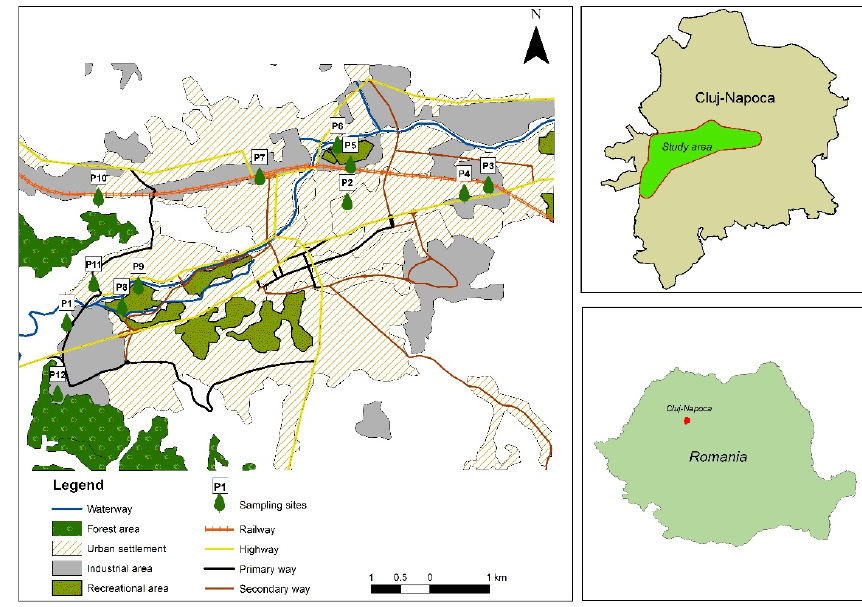
Figure 7. Map of study area and sampling points.